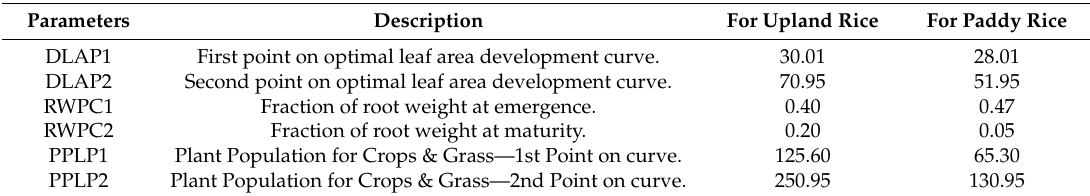
Table 3. Important crop parameters for simulating paddy rice compared with upland rice. Parameters